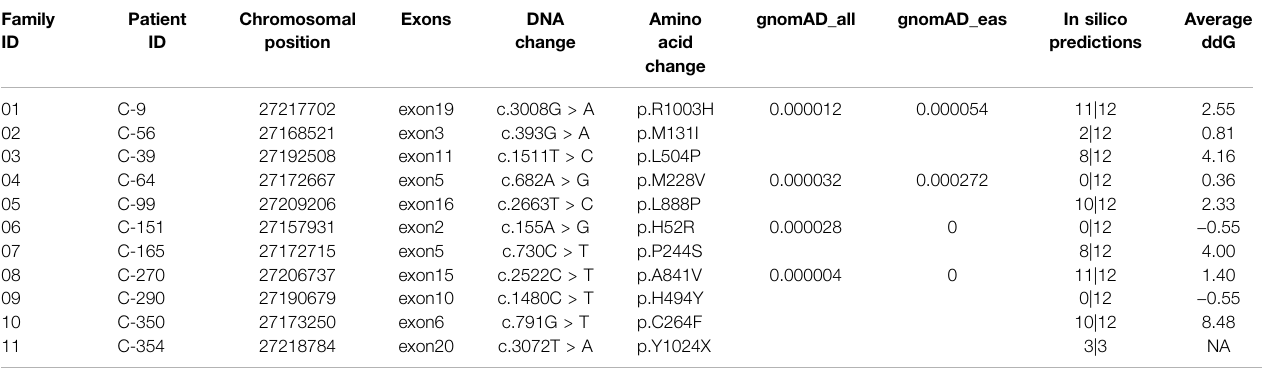
TABLE 1 | TEK variants identi fi ed in 11 families.